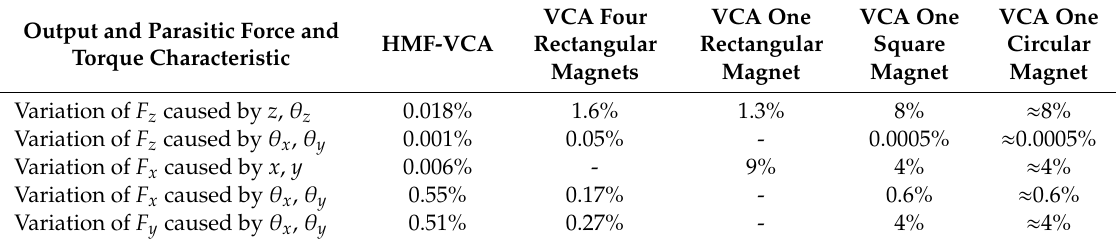
Table 2. Performance comparison of